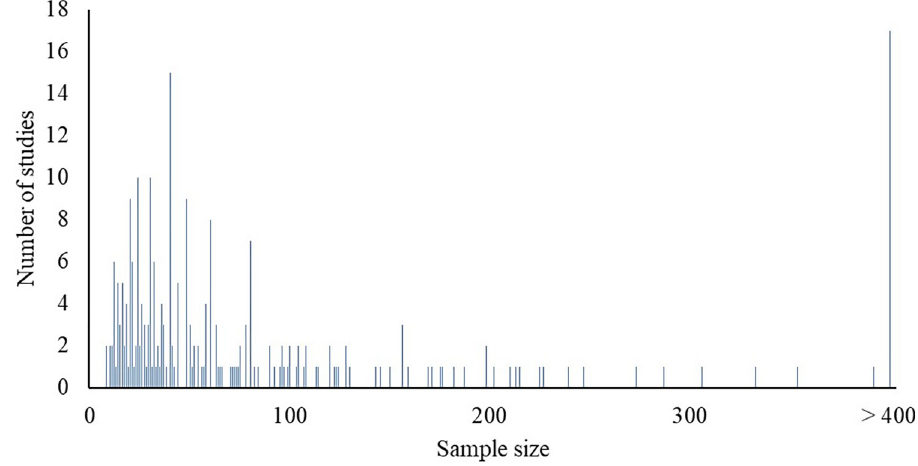
Fig 3. Distribution of the sample size used in studies (n = 254). Two studies had unclear or did not report the sample